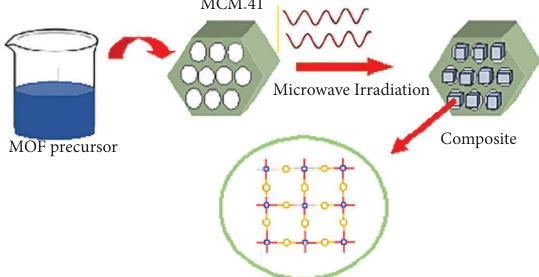
Figure 11: Synthesis of MCM-41@ MOF via microwave assisted methods adopted from